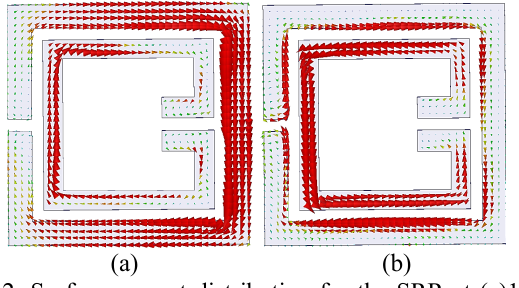
Figure 2: Surface current distribution for the SRR at (a)1.6 GHz and (b)2.89 GHz